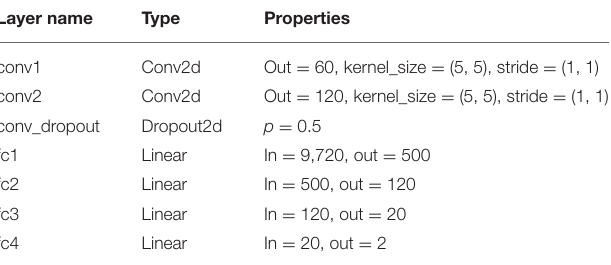
TABLE 2 | Simple Convolutional Neural Network structure (simple CNN) similar to Vortmann et al. (2021), implemented using the PyTorch library by Paszke et al. (2019). fc, fully connected.